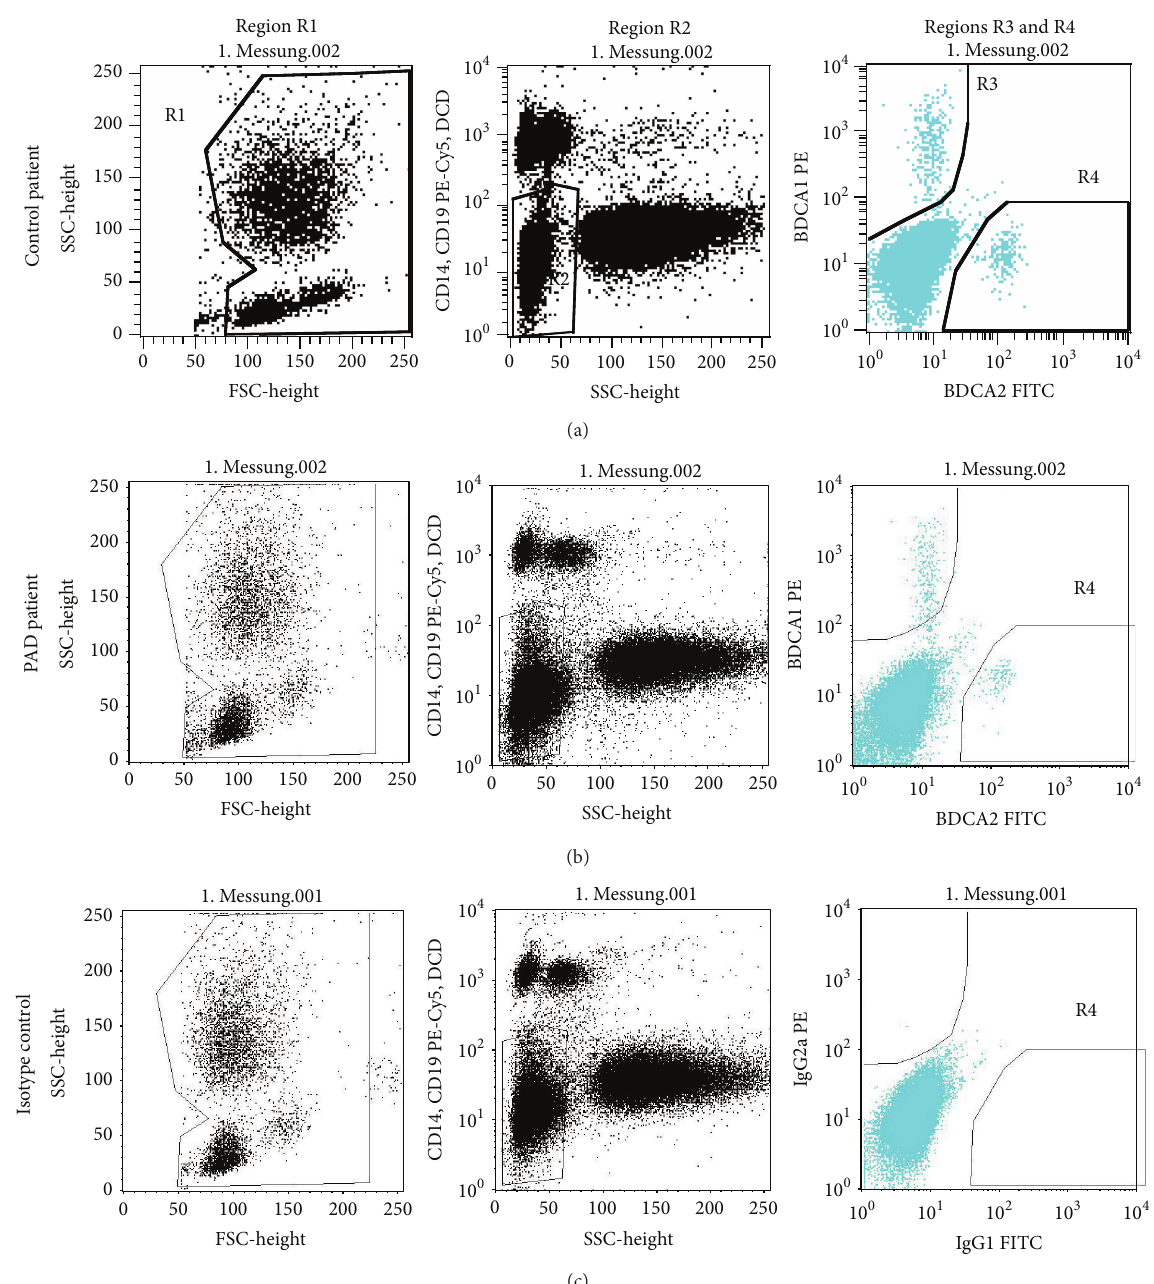
Figure 1: Gating strategy used for the identification of circulating mDCPs, pDCPs, and tDCPs by flow cytometry. (a) DCP analysis in control patients; (b) DCP analysis in patients with PAD; (c) isotype control. Region R1: white blood cells (WBCs) were separated from debris and platelets using their forward and side scatter (FSC and SSC). Region R2 was used to exclude granulocytes by SSC, B lymphocytes by CD19 staining, monocytes by CD14 staining, and dead cells by propidium iodide-staining. In regions R3 and R4, circulating mDCP and pDCP were detected according to their specific BDCA-1 and BDCA-2 staining,